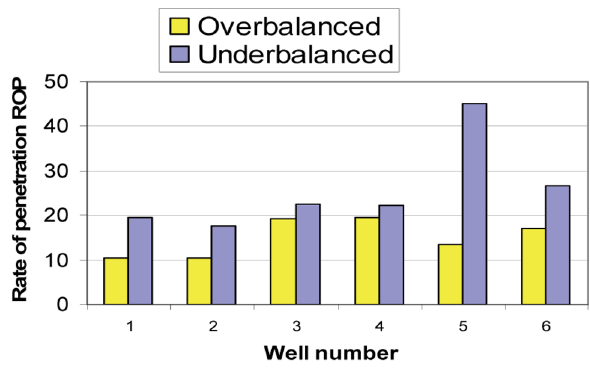
Fig. 3 Comparison between ROP in OB and UB cases. (Fattah et al.